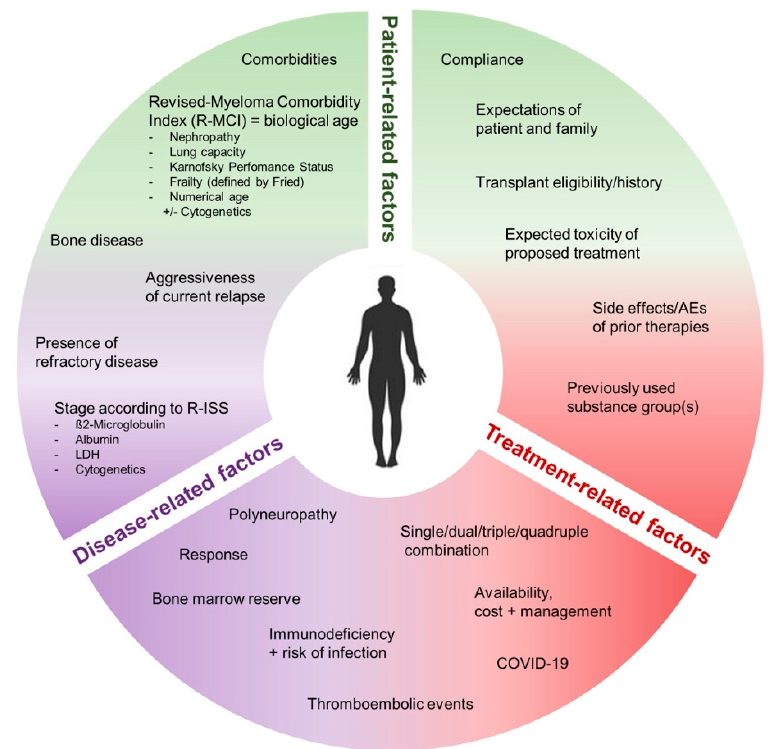
Figure 2. Relevant parameters for treatment selection in RRMM patients. In case of relapse, the choice of treatment should be adapted to patient-, disease- and treatment-related factors to define the best individual therapy for each patient. Over the course of the disease, an increase in myeloma- associated comorbidities, treatment toxicities and/or the natural process of aging make choosing the right treatment more difficult. Additionally, tolerability of previous treatments, the patient’s and family’s expectations, availability and management need to be considered. Abbreviations: AE = adverse events, COVID-19 = Coronavirus disease 2019, LDH = lactate dehydrogenase, R-ISS = revised international staging system, R-MCI = revised myeloma comorbidity index.